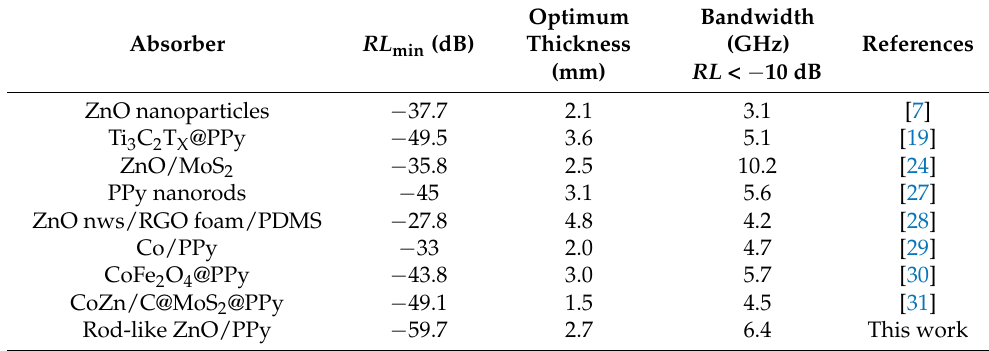
Table 1. MWA properties of related absorbers.